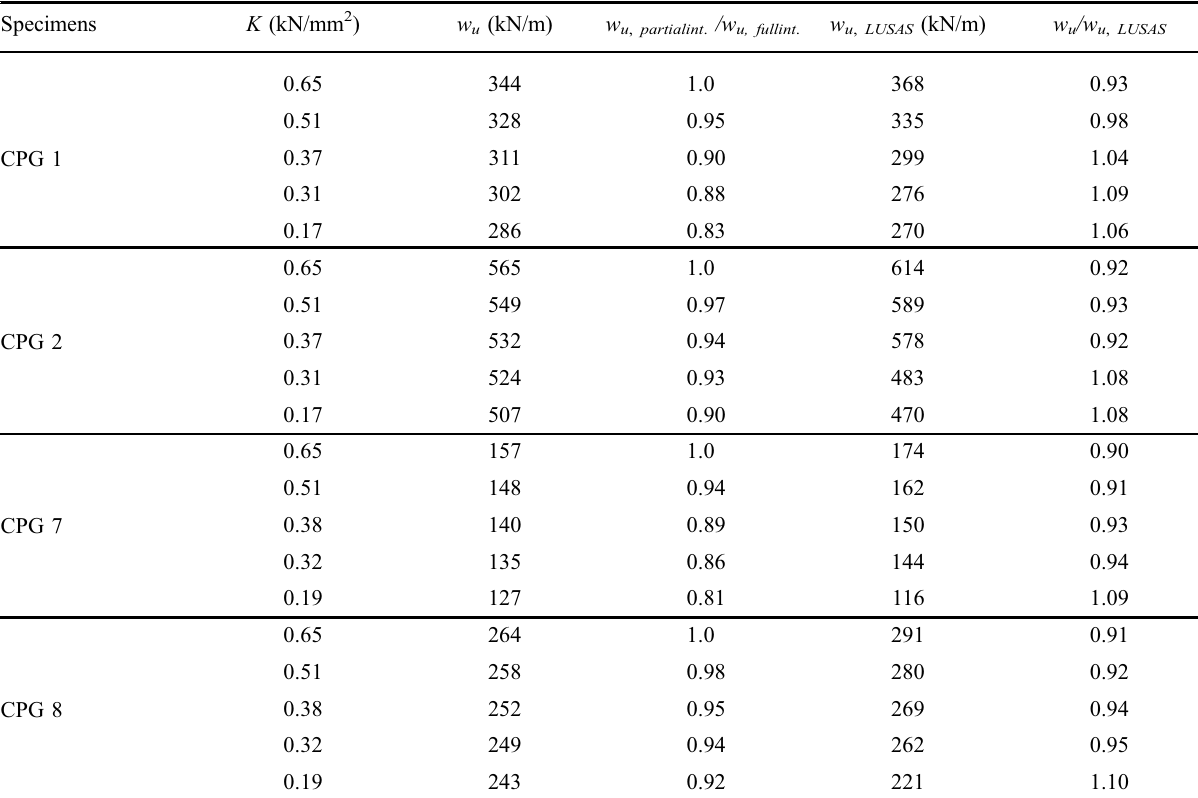
Table 3. Comparison of ultimate loads for girders under uniformly distributed load Specimens